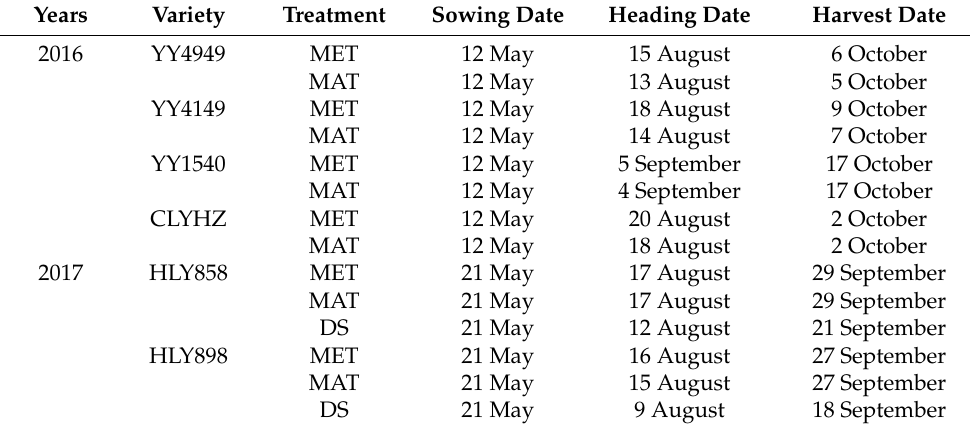
Table 1. The rice growth period in 2016 and 2017.